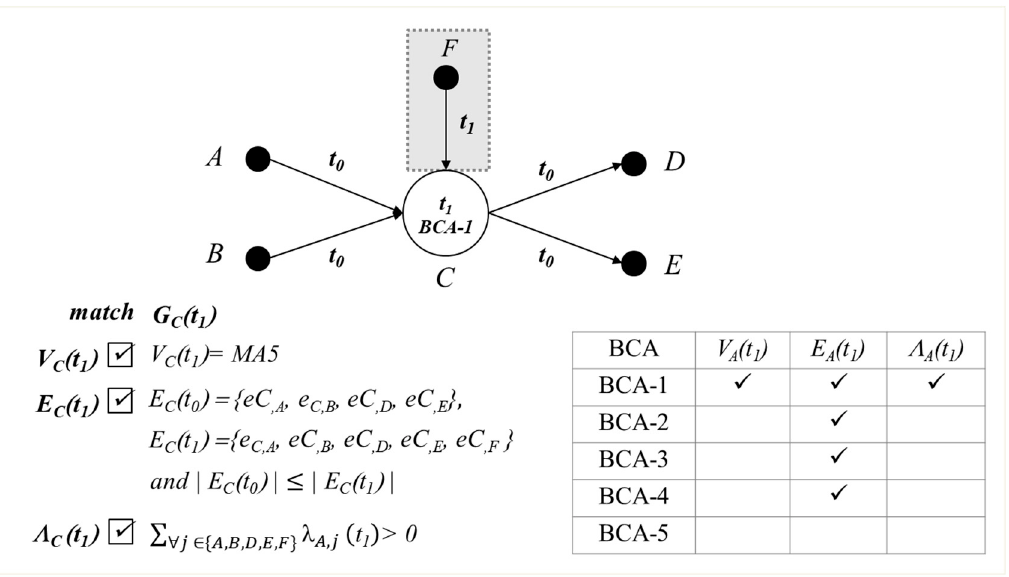
Figure 6. Example of root cause analysis.